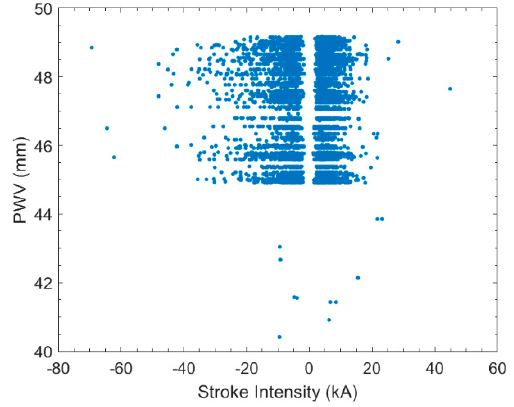
Figure 5. Scatterplot of PWV as a function of strokes intensity.